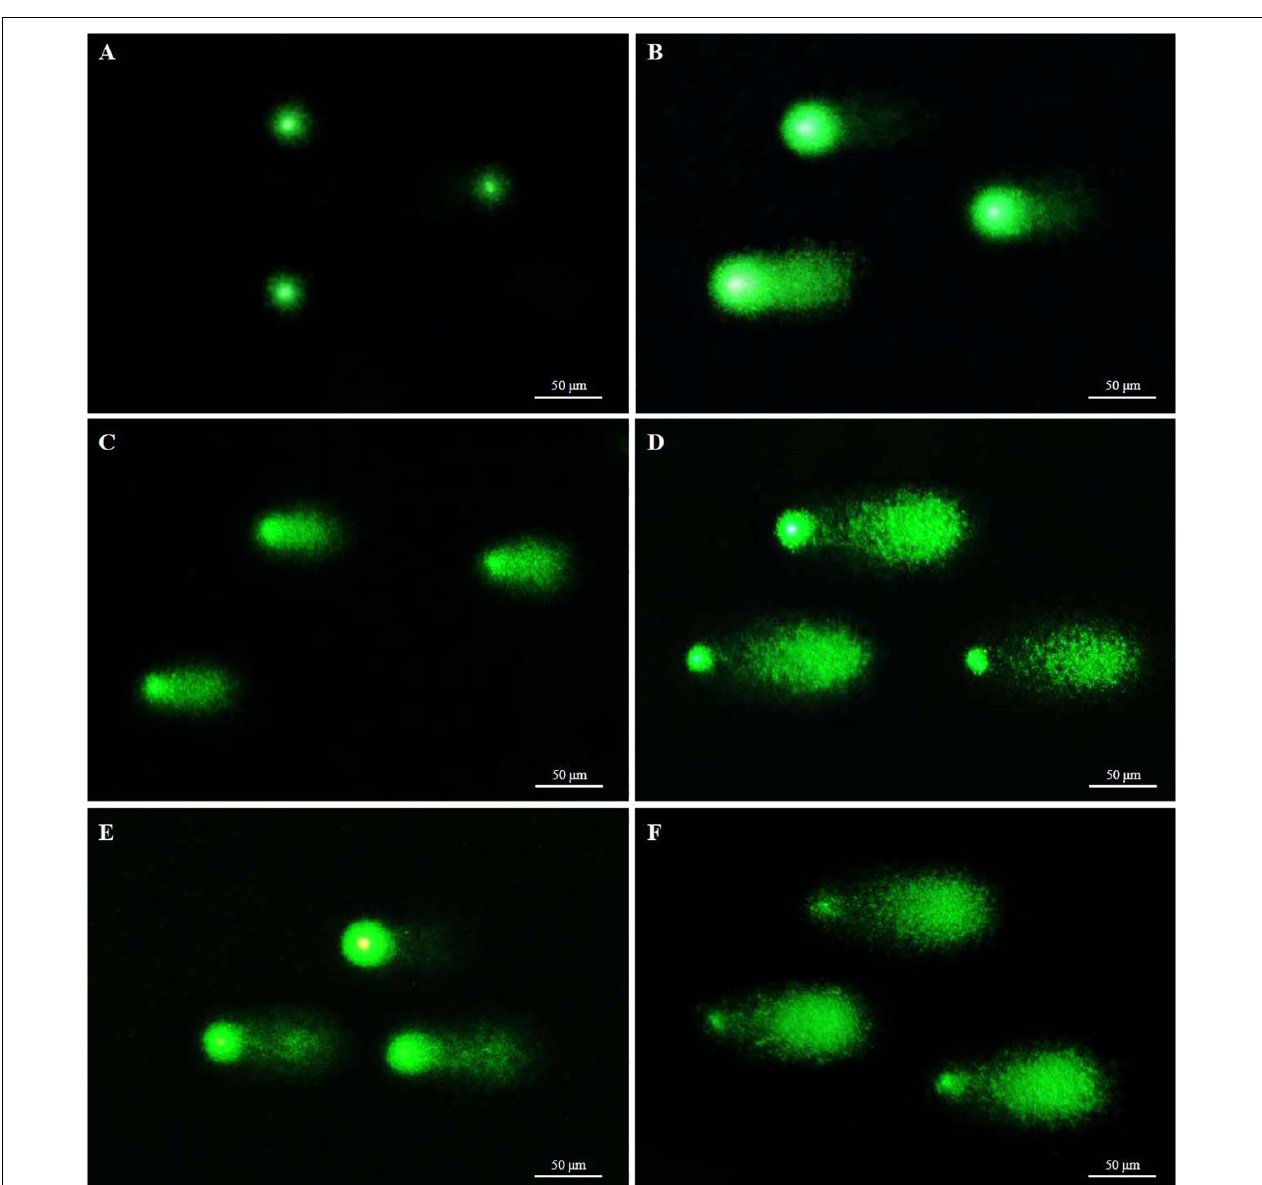
FIGURE 7 | Fluorescent images of fresh and cryopreserved sperm after comet assay. Each comet represents damaged or undamaged DNA in sperm. (A) Intact nuclei of fresh sperm; (B) slightly damaged nuclei of sperm cryopreserved with 8% Me 2 SO; (C) slightly damaged nuclei of sperm cryopreserved with 8% EG; (D) fragmented tail DNA of sperm cryopreserved with 6% PG; (E) slightly damaged nuclei of sperm cryopreserved with 2% GLY; and (F) fragmented tail DNA of sperm cryopreserved with 2% MeOH. The comet gel was stained with Vista green dye.